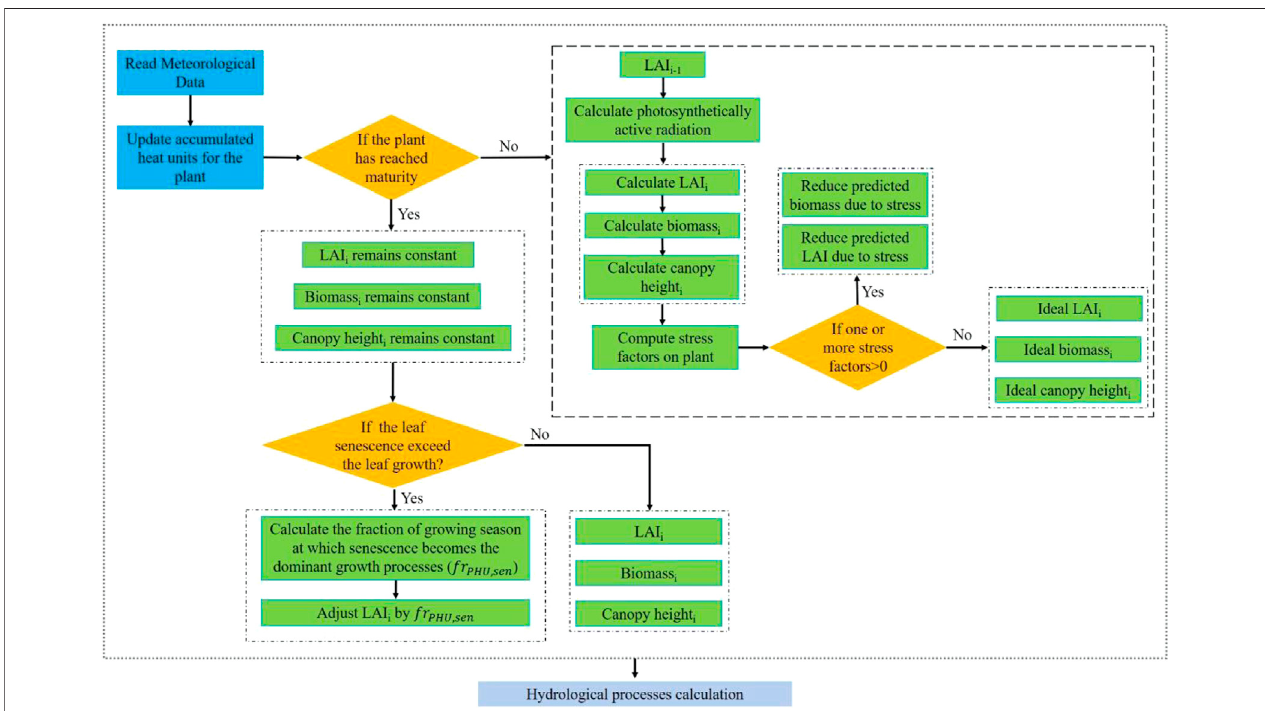
FIGURE 1 | The plant growth module of the original Soil and Water Assessment Tool (SWAT) model.